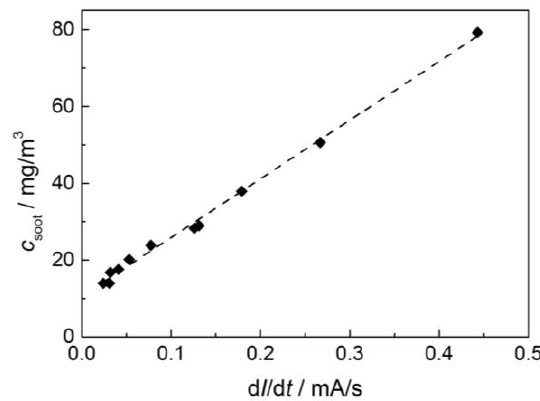
Figure 5. Correlation of the timely differentiated resistive soot sensor signal, d I /d t , and the soot concentration in the exhaust, c soot , as determined by the Pegasor sensing device. The dashed regression line follows the equation: c soot /mg/m 3 = 152.76 · d I /d t /(mA/s) + 10.6.